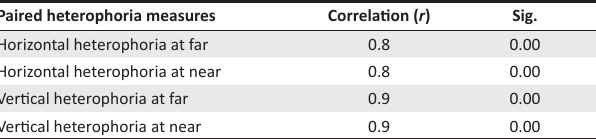
TABLE 3: Pearson coefficients of correlations between heterophoria measured using the phoropter and trial frame. Paired heterophoria measures